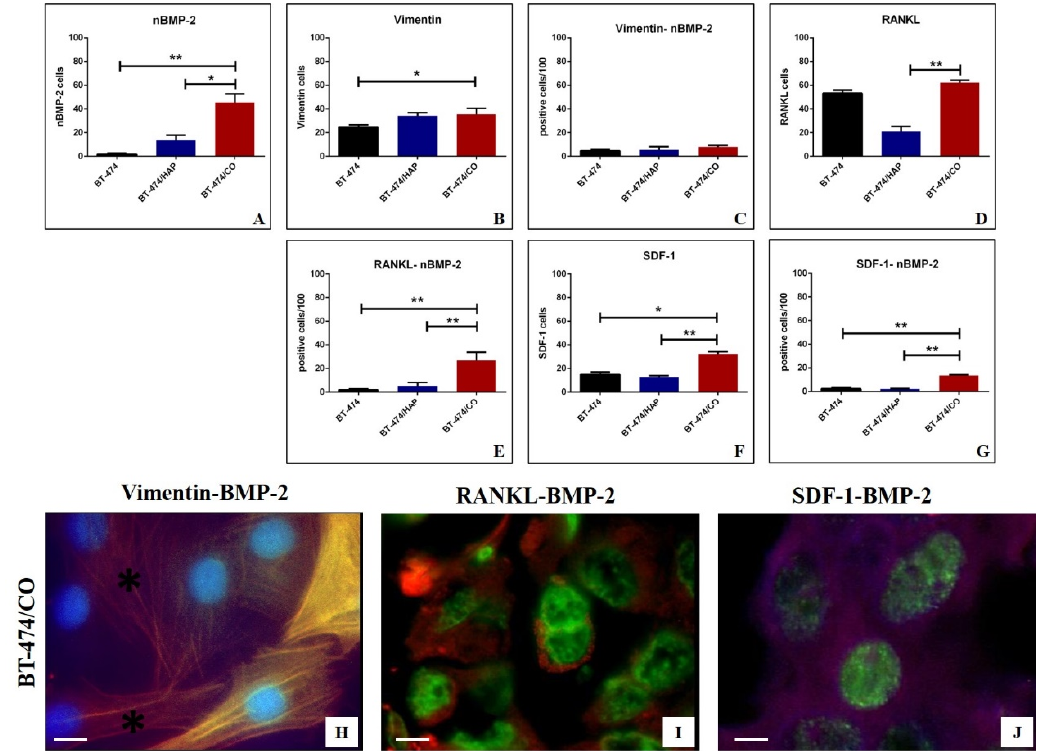
Figure 5. In vitro analysis of BMP-2 and RANKL expression in BT-474 breast cancer cells showing an osteoblast-like phenotype ( A ) The graph displays the number of nBMP-2-positive breast cells among the BT-474, BT-474 / HAP, and BT-474 / CO groups. ( B ) The graph shows the number of vimentin-positive breast cells among the BT-474, BT-474 / HAP, and BT-474 / CO groups. ( C ) The graph displays the number of vimentin-nBMP-2-positive breast cells among the BT-474, BT-474 / HAP, and BT-474 / CO groups. ( D ) The graph shows the number of RANKL-positive breast cells among the BT-474, BT-474 / HAP, and BT-474 / CO groups. ( E ) The graph displays the number of RANKL-nBMP-2-positive breast cells